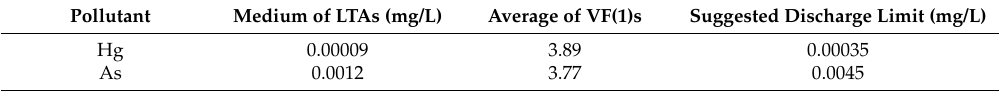
Table 11. Suggested Hg and As discharge limits of WWTPs in